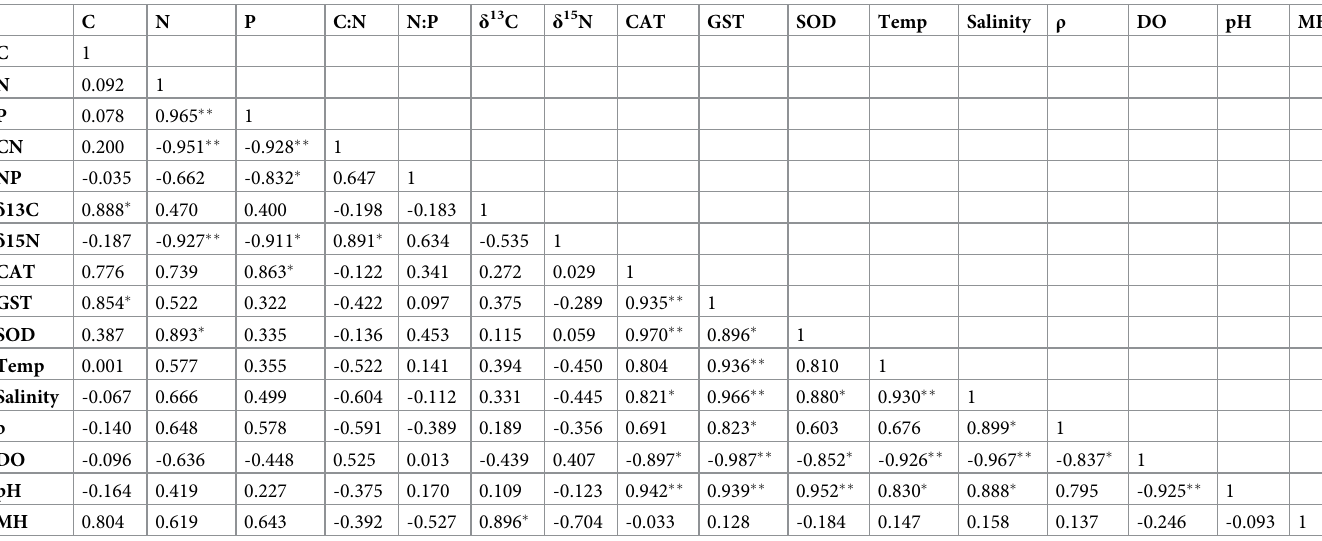
Table 6. Pearson correlation coefficient between potential stressors, antioxidants and mangrove height at 6 sites on the coast of the central Red Sea, Saudi Arabia. C N P C:N N:P δ 13 C δ 15 N CAT GST SOD Temp Salinity ρ